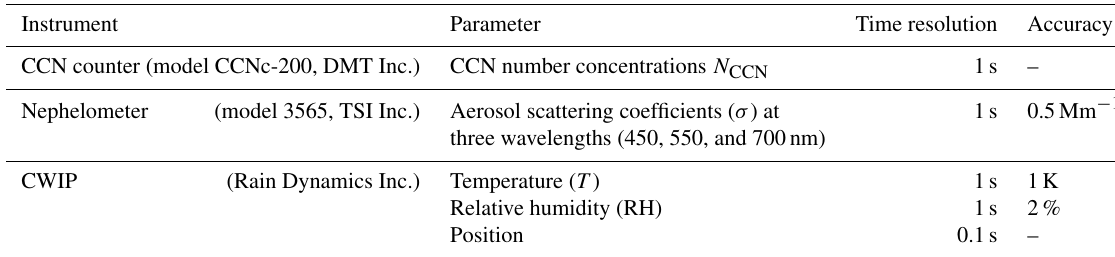
Table 2. Instruments equipped on the Y-12 airplane used in this study.